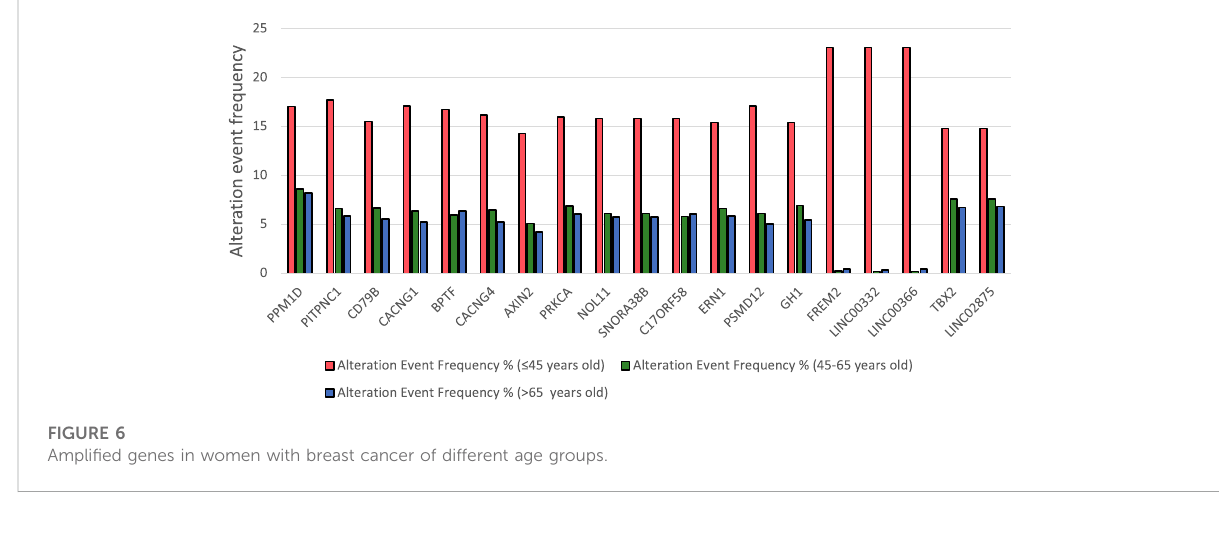
FIGURE 6 Ampli fi ed genes in women with breast cancer of different age groups.